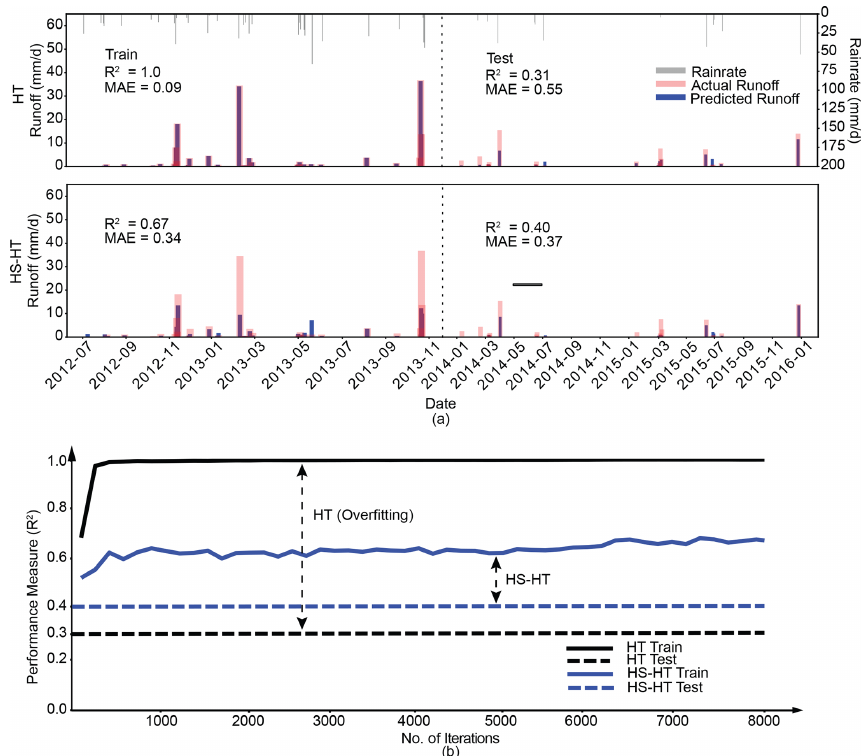
Figure 5. (a) Comparison of the performance of the XGBoost models in prediction of daily EOF runoff for the Maumee domain with respect to the observed runoff preceded by the HT approach and the proposed framework (i.e., the HS–HT approach) for a given period. The upper x axis shows the rainfall intensity (mmd − 1 ) over the training (July 2012–December 2013) and test (January 2014–January 2016) period, respectively. (b) Comparison of the performance of the XGBoost models preceded by the two approaches, HS–HT and HT, with respect to the number of iterations. The double-headed arrows indicate the differences in R 2 values between the training and test for each approach.